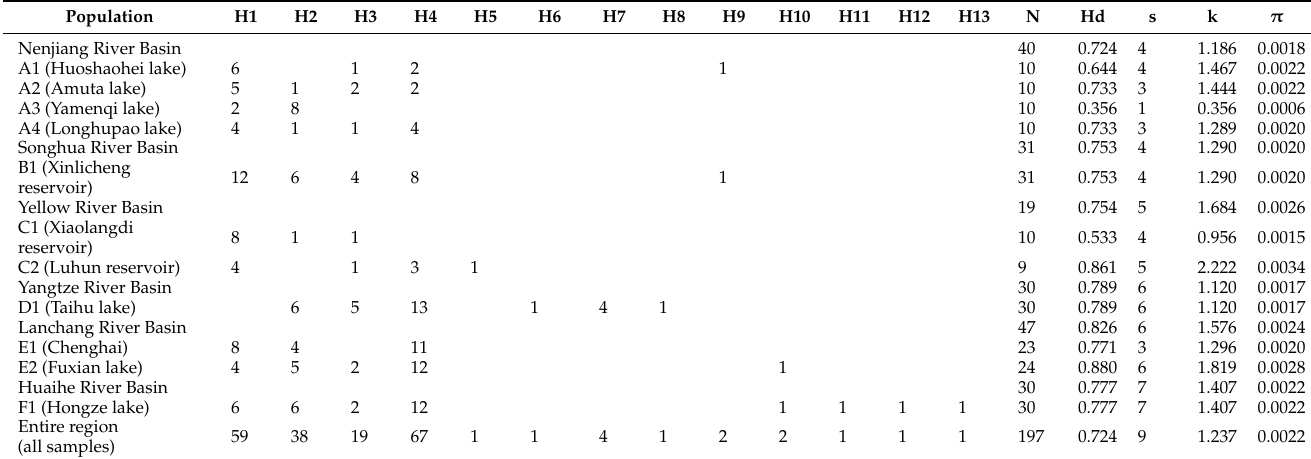
Table 2. Genetic diversity indices of different N. taihuensis